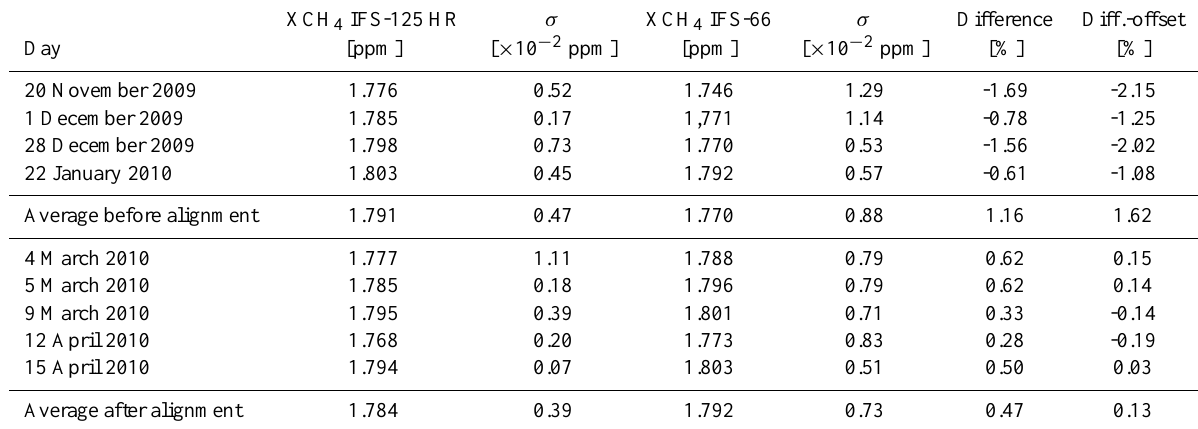
Table 3. Daily means of XCH 4 for nine measuring days. The statistics are calculated as described for XCO 2 in Table 2. In the last column an offset of 0.47% is subtracted from the daily means measured by the IFS-66, then the difference is calculated and given in percent. Again, the averages of differences are calculated from the absolute